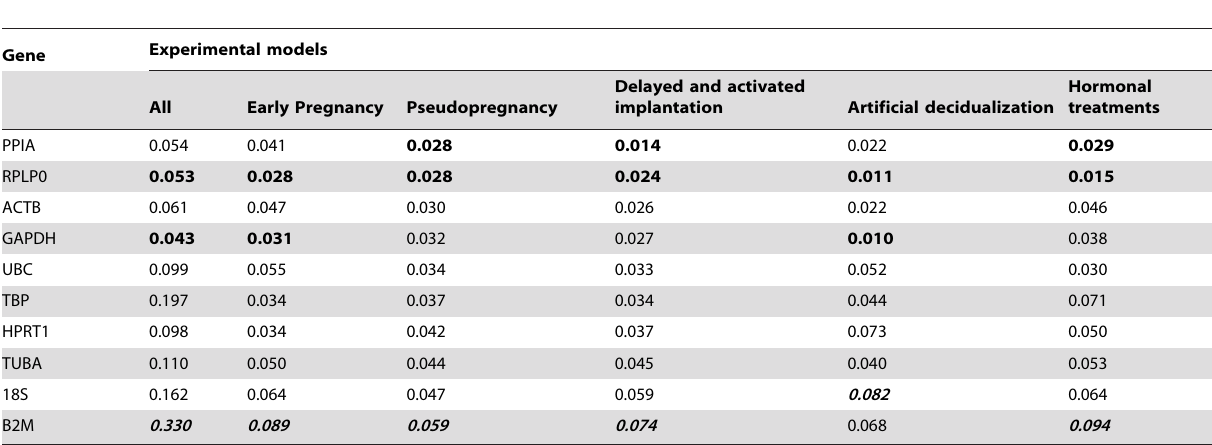
Table 3. Ranking of candidate reference genes in order of their expression stability as calculated by NormFinder.